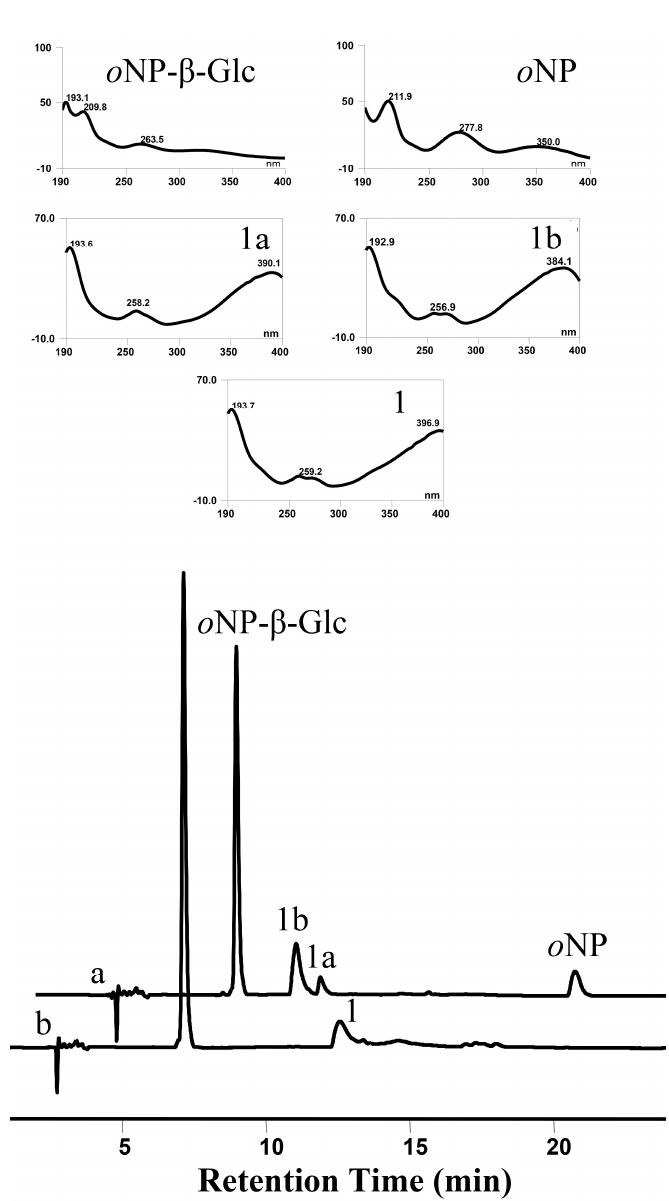
Figure 6. HPLC chromatogram of transglucosylation reaction sulfuretin (1) and o NP- β -Glc mediated by OsUGT1 (a) or no OsUGT1 (b). UV spectra of 1, 1a, 1b, o NP- β -Glc and o NP are shown in upper panels. o NP- β -Glc: o -nitrophenyl- β - D -glucopyranoside; o NP: o -nitrophenol. panels. o NP- β -Glc: o -nitrophenyl- β - D -glucopyranoside; o NP: o